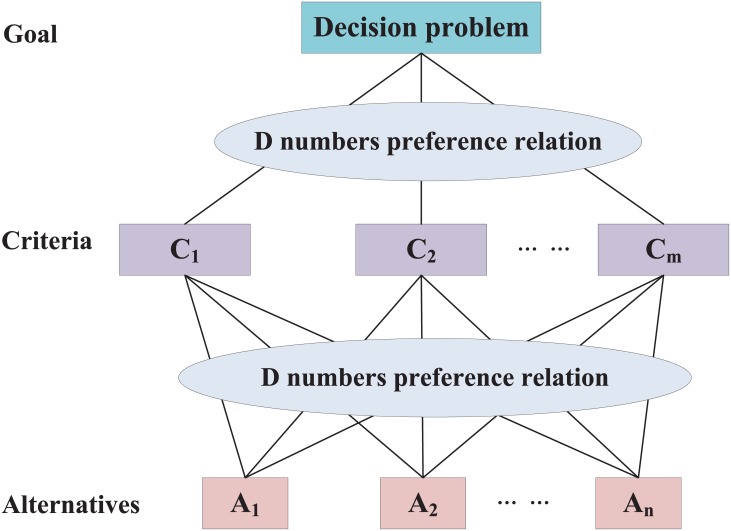
The framework of D-AHP approach [23].